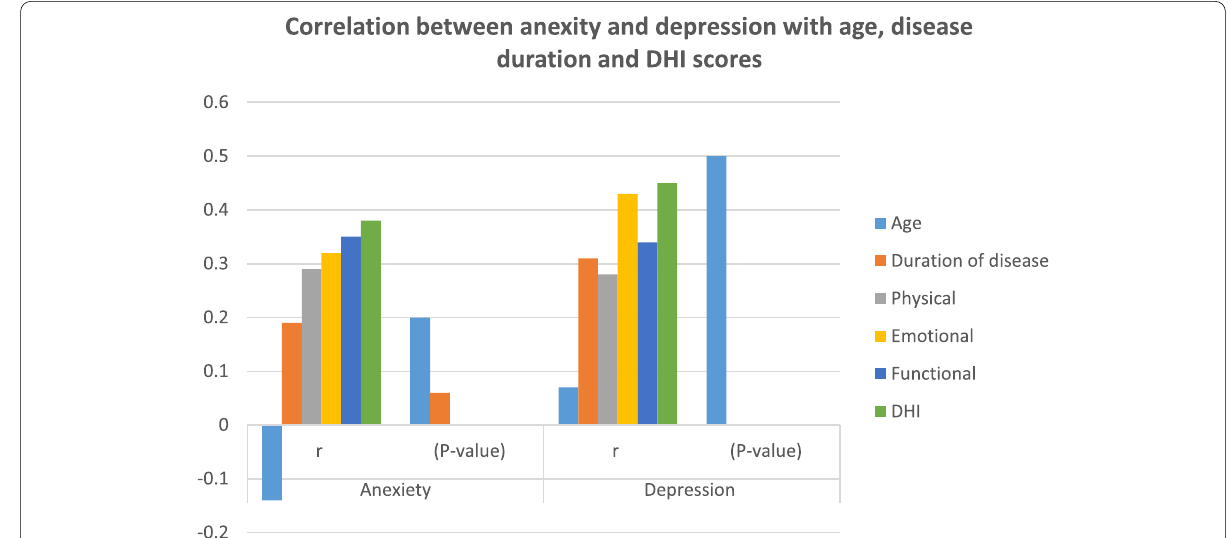
Fig. 1 Correlation between anxiety and depression with age, disease duration, and DHI